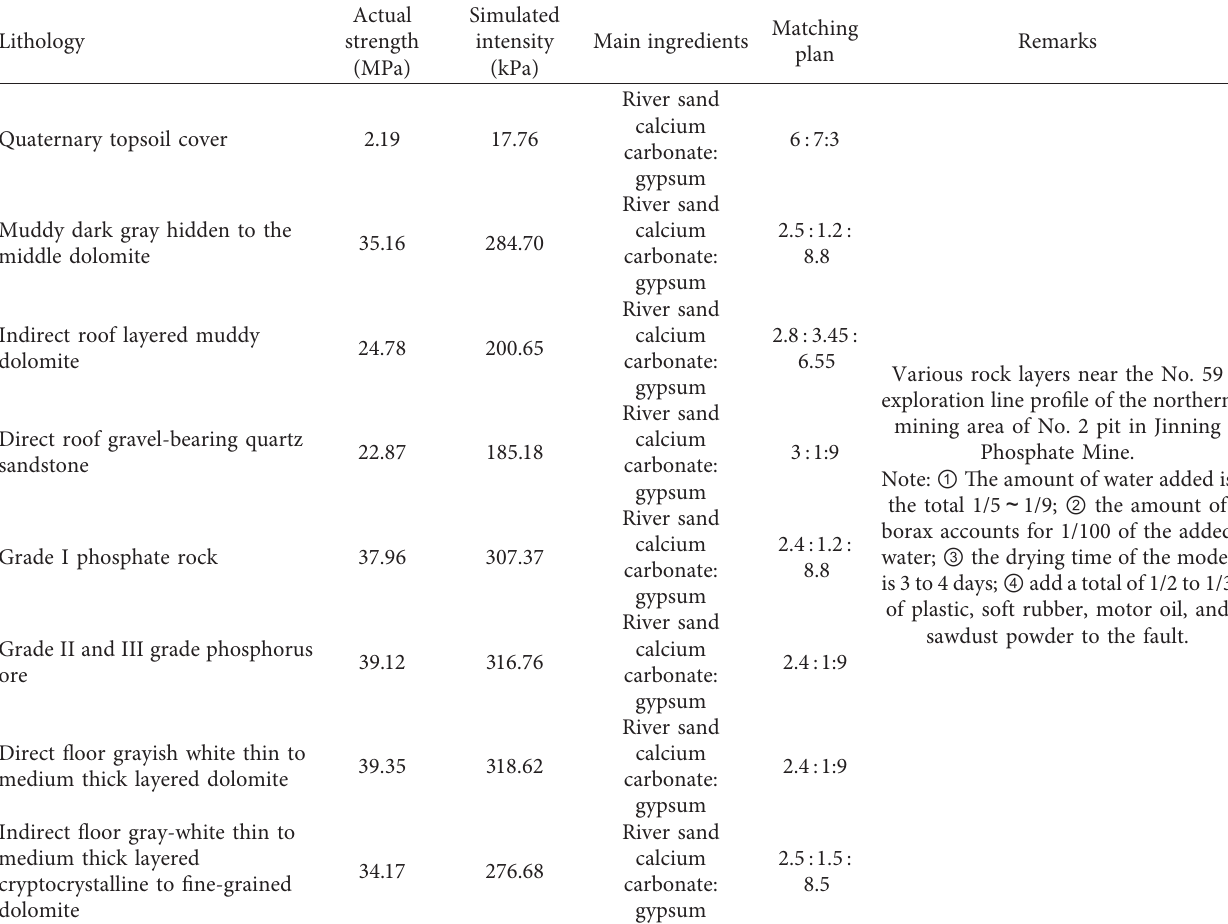
Table 1: The final mixing proportioning scheme of field strata.